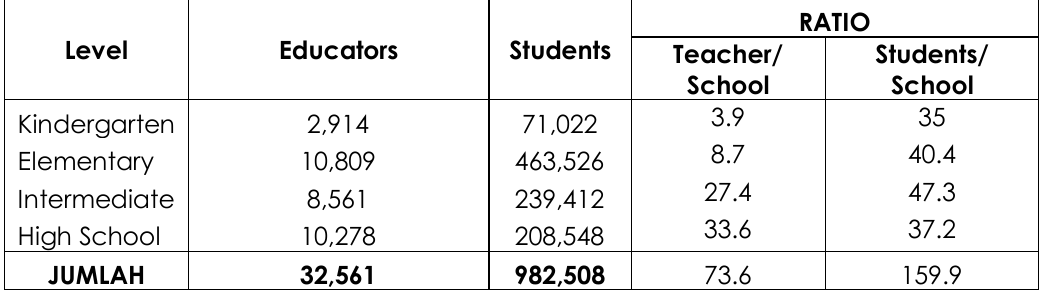
Table 2. Vocational Educators and High School Students Bandung